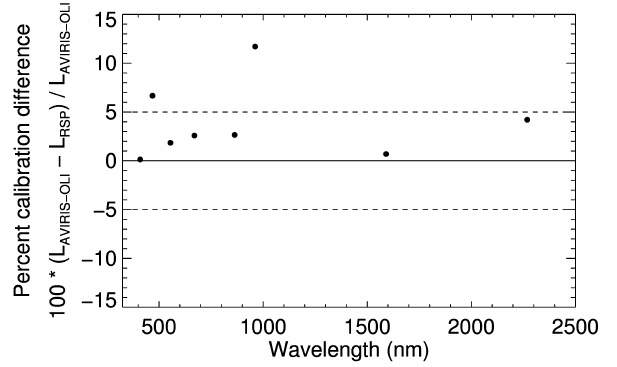
Figure 11. Comparisons of RSP and AVIRIS over a wide dynamic range for best (410nm) and worst (960nm)